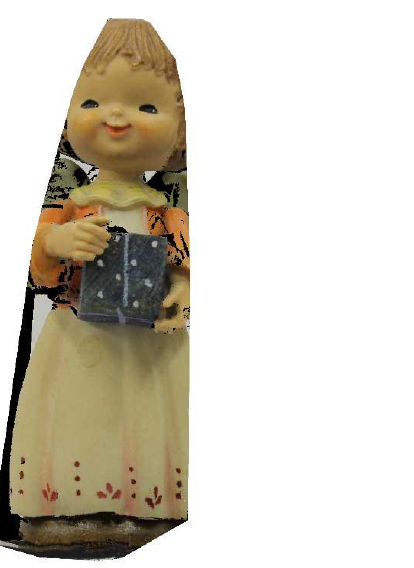
Figure 8. Difference image.